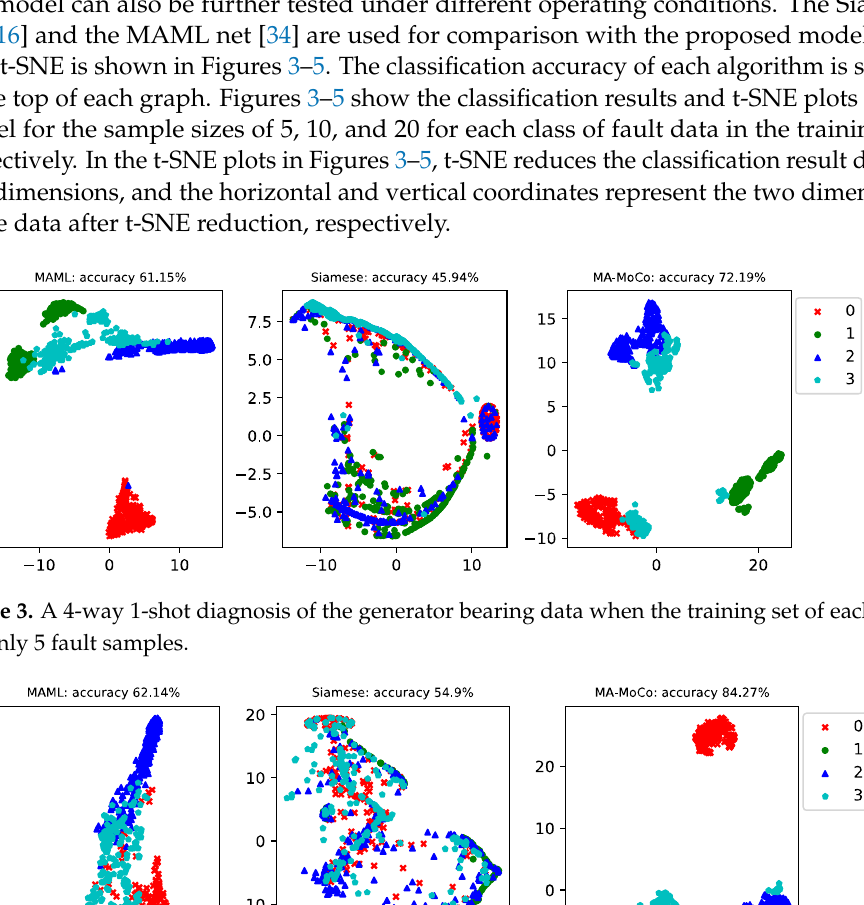
Figure 5. A 4-way 1-shot diagnosis of the generator bearing data when the training set of each class has only 20 fault samples. The fault classification accuracy of the generator bearings for wind turbines using different algorithms is shown in Figure 6. In order to analyze the influence of different sample sizes in the training set on the diagnostic accuracy of the model, this paper inves- tigates the diagnostic accuracy of the model when the sample sizes of each type of fault in the training set are 5, 10, and 20, respectively. It can be seen that the higher the training sample size, the higher the classification accuracy of the model. The average accuracy of MA-MOCO is 18.05% higher than MAML and 25.59% higher than Siamese net. Figure 6. A 4-way 1-shot diagnosis of the accuracy of the generator bearing data when the training set of each class has 5, 10, and 20 fault samples.